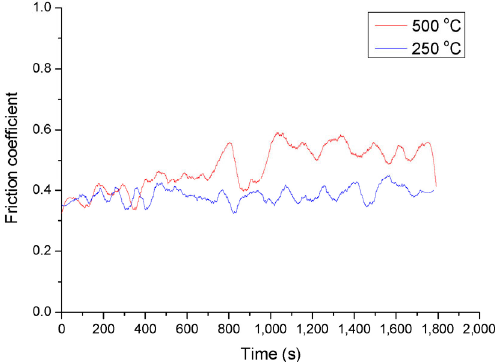
Fig. 11 Coefficient of friction of the CoCrFeNiTi 0.5 Al alloy as a function of sliding time at different temperatures.